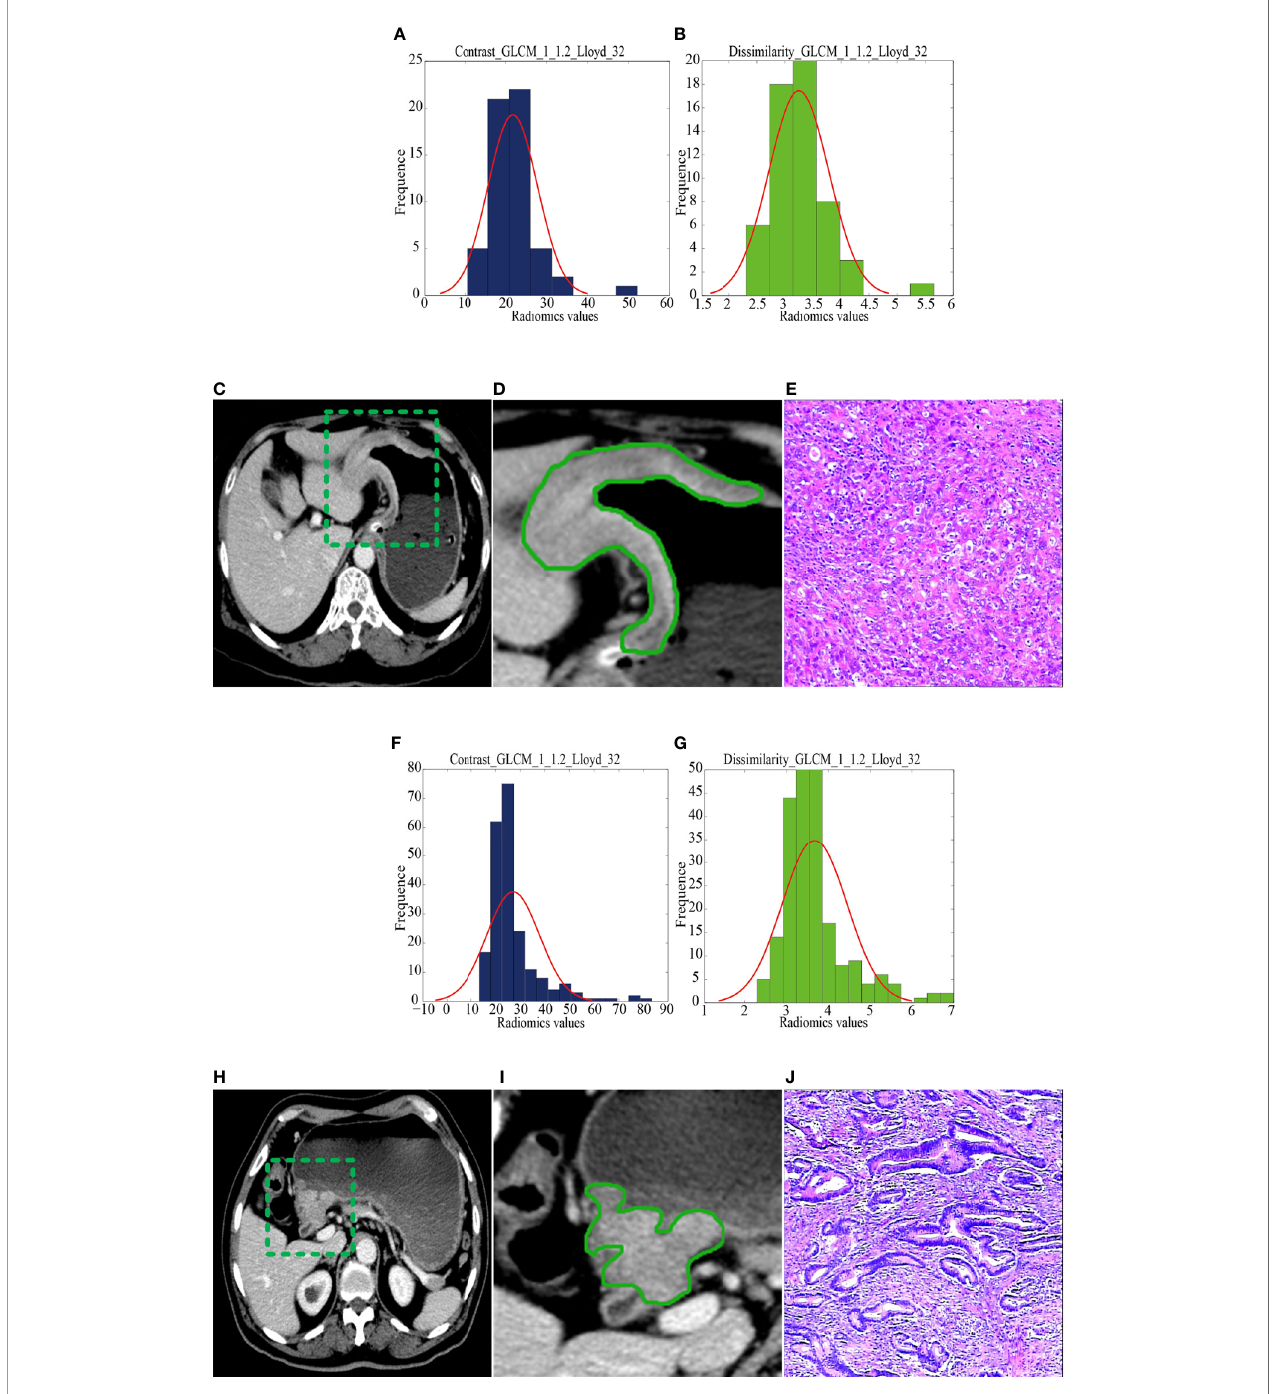
FIGURE 2 | CT images and selected feature parameters in the recurrence group (RG) and nonrecurrence group (NRG). (A) to (E) , A 68-year-old man in the RG. (A, B) , The feature parameter maps of Contrast_GLCM_1_1.2_Lloyd_32 and Dissimilarity_GLCM_1_1.2_Lloyd_32 had average values of 21.80 ± 6.03 and 3.25 ± 0.54, respectively. (C, D) , The portal venous contrast-enhanced CT images showed a lesion. (E) This lesion was fi nally con fi rmed as diffuse-type gastric cancer by histopathological analysis (H&E, 400×). (F) to (J) , A 56-year-old man in the NRG. (F, G) , The feature parameter maps of Contrast_GLCM_1_1.2_Lloyd_32 and Dissimilarity_GLCM_1_1.2_Lloyd_32 had average values of 27.17 ± 10.71 and 3.67 ± 0.78, respectively. (H, I) , The portal venous contrast-enhanced CT images showed a lesion. (J) This lesion was fi nally con fi rmed as mixed-type gastric cancer by histopathological analysis (H&E,